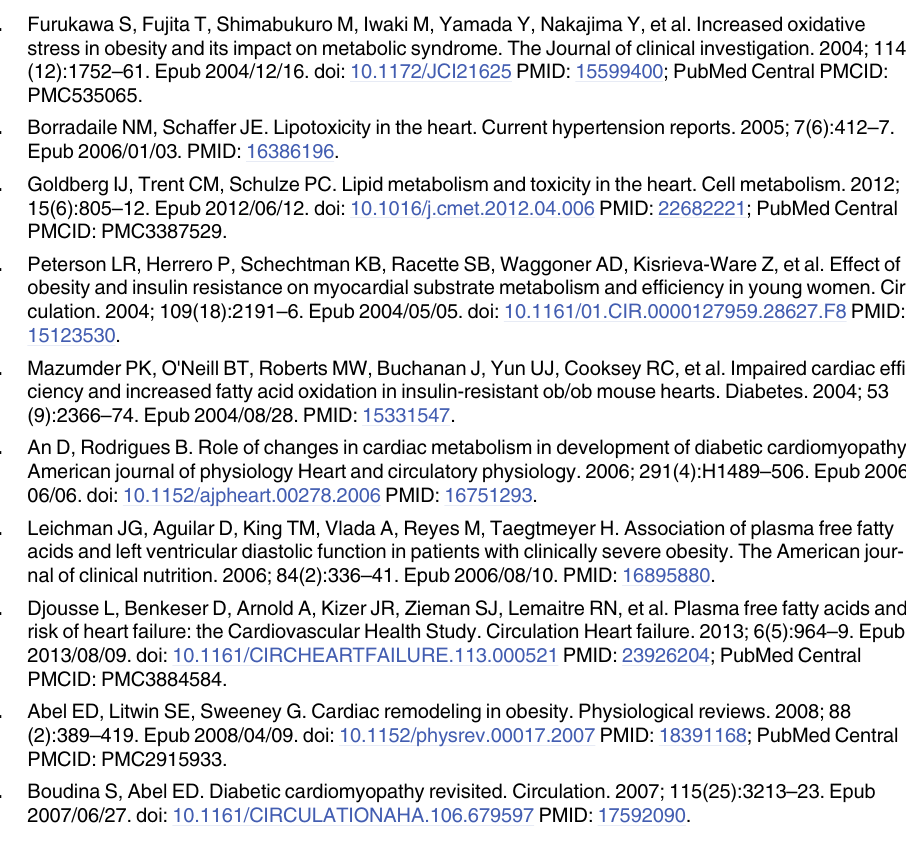
S1 Table. Primer sequences for quantitative polymerase chain reaction q-PCR. S2 Table. List of primary antibodies used in the study. S3 Table. Statistical analysis of data presented in Fig 7. S4 Table. Statistical